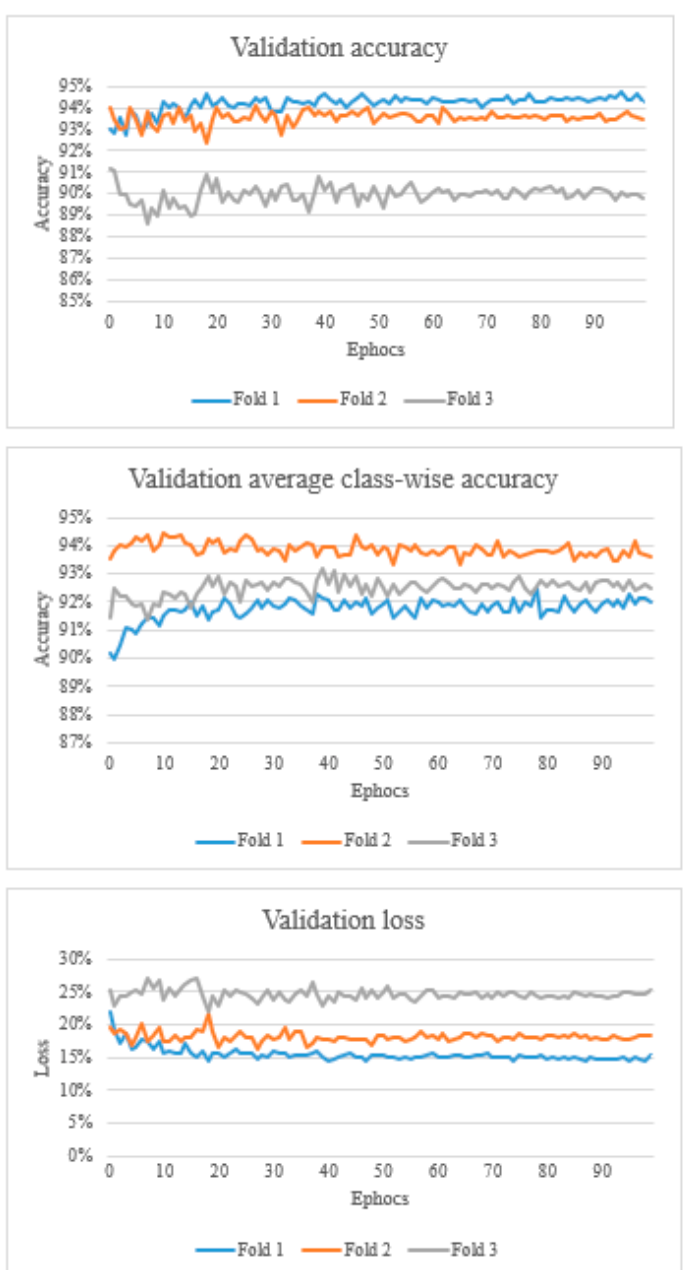
Figure 3. The top graph shows the validation accuracy, the middle graph shows the validation average class-wise accuracy, and the bottom graph shows the validation loss.